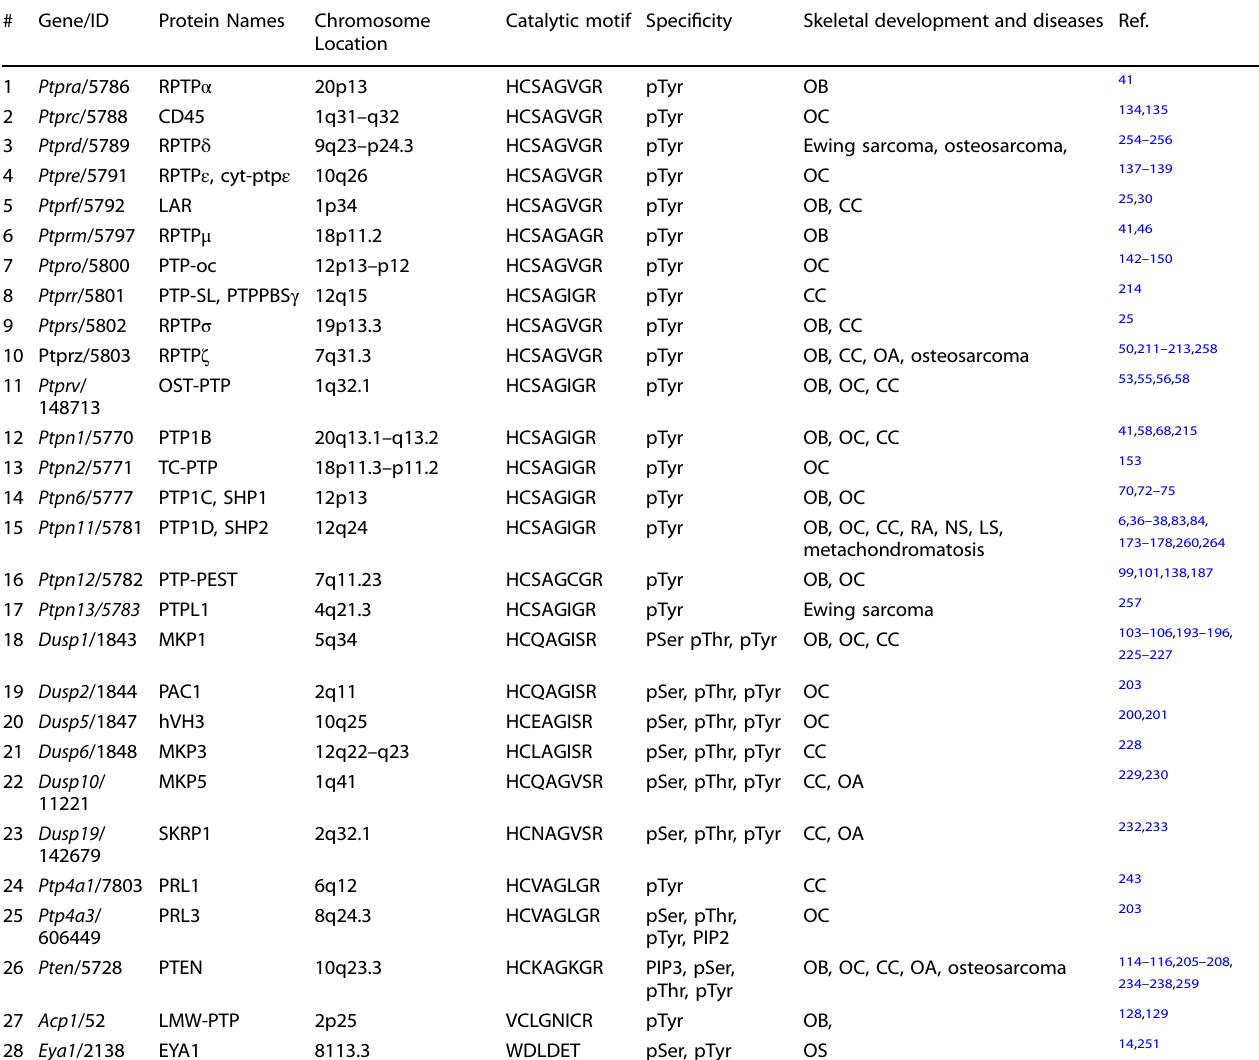
Table 1. Twenty-eight PTPs involved in skeletal development and human skeletal